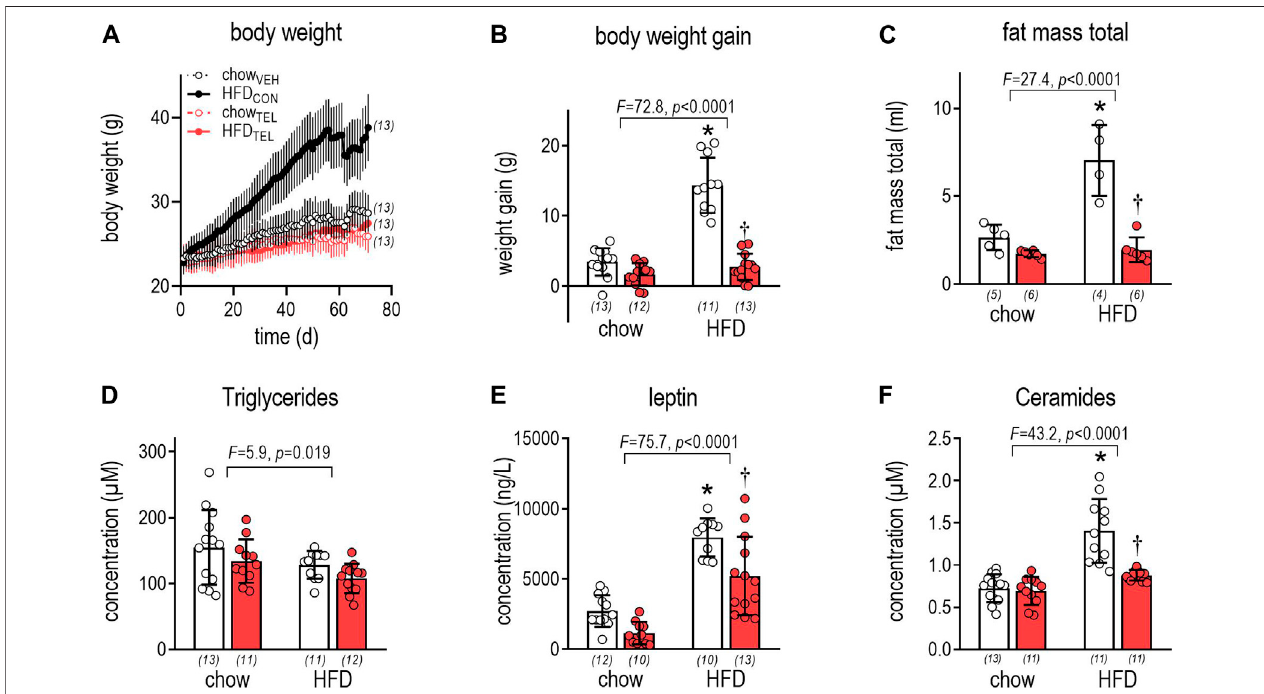
FIGURE 1 | Growth of mice that were fed either with chow or high fat diet (HFD). Mice were treated with TEL ( C , 8 mg/kg/day red bars) or vehicle treatment open bars (O). (A) :time-dependentincreaseinbodyweight(forresultsofthree-wayofANOVAsee SupplementaryTableS1 ); (B) weightgainwithintheexperimental period of 12 weeks (two-way ANOVA; TEL: F = 90.8, p < 0.0001, interaction; F = 49.3, p < 0.0001); (C) total fat mass after 10 weeks of treatment (two-way ANOVA; TEL: F = 46.5, p < 0.0001, interaction; F = 22.2, p = 0.0002); (D) TG plasma concentrations after 12 weeks (two-way ANOVA; TEL: F = 3.6, p = 0.063, interaction; F =